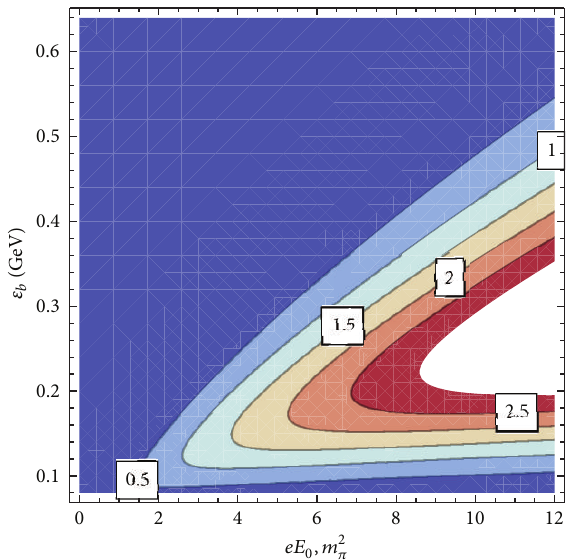
Figure 14: Contour plot of the dissociation rate of 𝐽/𝜓 as a function of 𝜀 𝑏 and 𝑒𝐸 0 at 𝑒𝐵 0 = 15𝑚 2 𝜋 , 𝜙 = 𝜋/2 (in the reaction plane), 𝜂 = 0 (midrapidity), and 𝑃 ⊥ = 0.1 GeV. Numbers inside boxes indicate the values of 𝑤 in